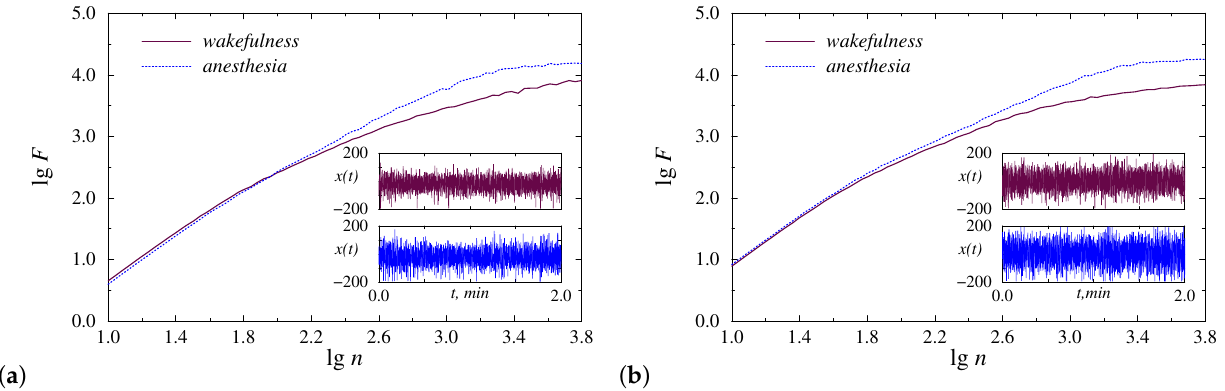
Figure 1. Examples of nonlinear behavior of F ( n ) on a log–log plot for injection ( a ) and inhalation ( b ) anesthesia. Insets show fragments of the original EEG signal from each